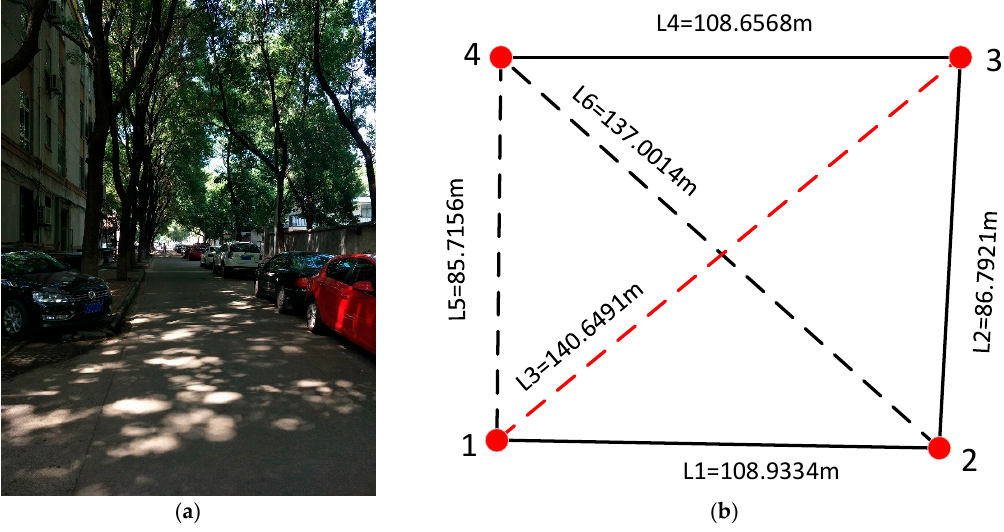
Figure 5. ( a ) field test environment; ( b ) control network.